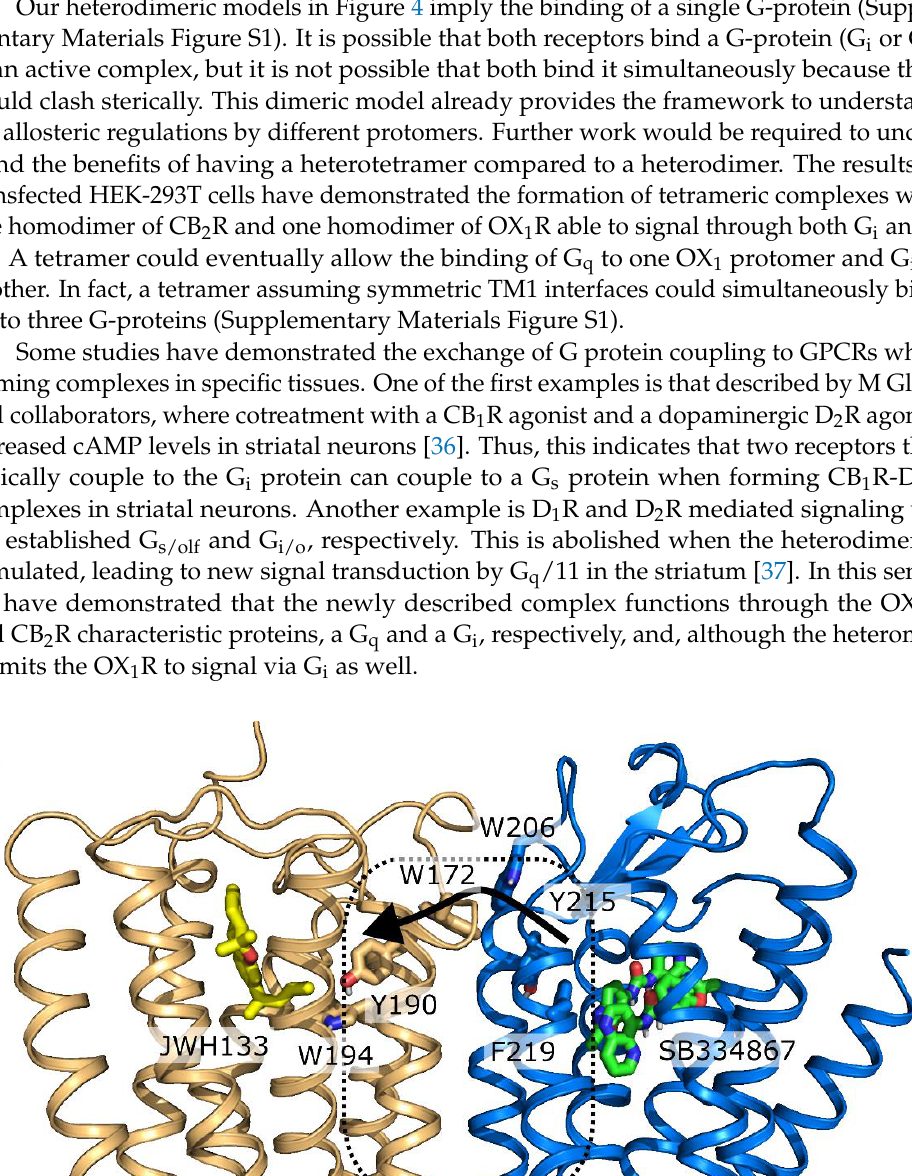
Figure 5. Computational model of the heteromeric TM4/5 CB 2 R-OX 1 R interface. ( A , B ) The possible modulation (indicated by the black arrows) of an antagonist to a neighbor receptor through a net- work of aromatic residues connecting both orthosteric sites, viewed from the membrane. ( A ) the CB 2 R/JWH133-OX 1 R/SB334867 complex; The experimental structure of the OX 1 R antagonist SB334867 revealed the presence of two copies of the ligand in the binding pocket interacting anti- parallelly with each other, which resulted in a large ligand volume near TM5. ( B ) The CB 2 R/SR144528-OX 1 R/orexin-A. Similarly, the CB 2 R antagonist SR144528 puts an aromatic ring at the region where most CB ligands place the alkyl chain (such as in JHW133), also towards TM5. The CB 2 R receptor is shown in gold and the OX 1 R receptor in blue. Small-molecule ligands and aromatic side chains connecting the pockets are shown as sticks; orexin-A with a thick green cartoon. Dotted boxes indicate TMs 4 and 5 of both receptors. In ( C ) detail of the CB 2 R/SR144528-OX 1 R/orexin-A complex viewed from the extracellular side superposing different orientations of the extracellular portion of TM5 and proximal region of the second extracellular loop (ECL2) (i) from the OX 2 R/orexin-B complex (PDB id 7L1U, cylinder and loop in light blue), which would clash sterically